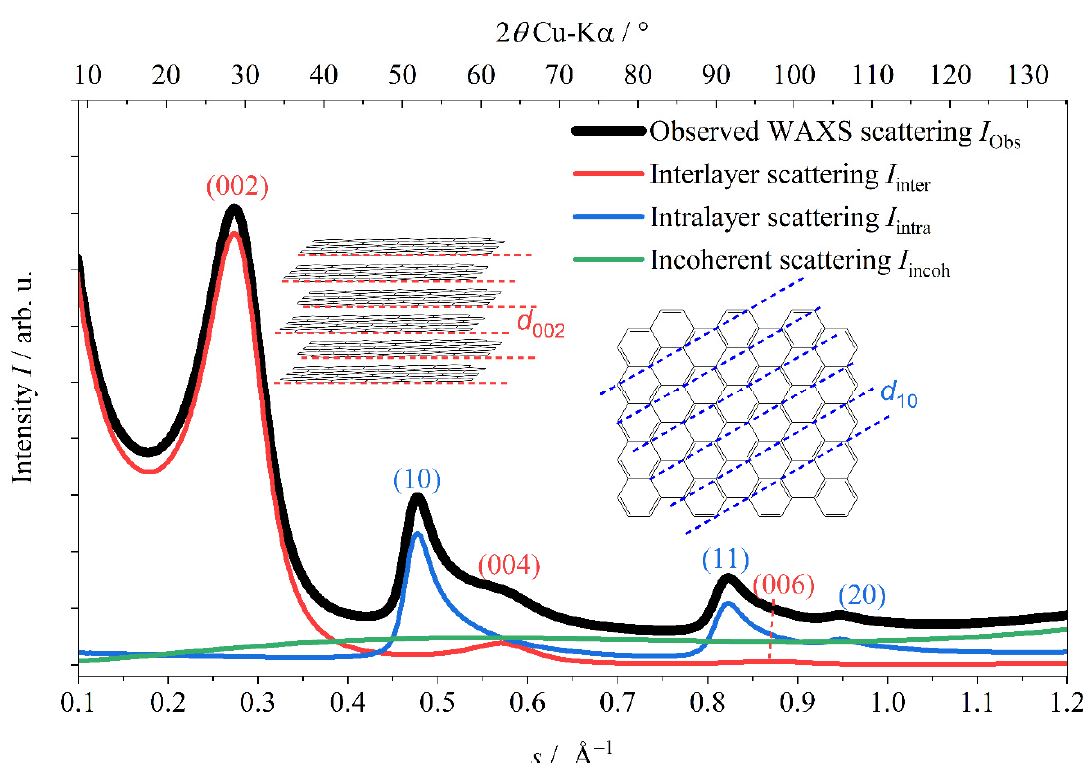
Figure 2. Representative example for an experimental wide-angle X-ray scattering (WAXS) data set of a NGC, which is given by a superposition of interlayer reflections (00 l ), asymmetric intralayer reflections ( hk ) and the incoherent scattering ( I incoh ). s is the modules of the scattering vector ( s = 2/ λ · sin( θ )). It should be noted that the indexing shown with parentheses, strictly speaking, denotes lattice planes, and that reflections would have to be indexed without parentheses. However, brackets are coherently used in this publication for both meanings, for improving readability.